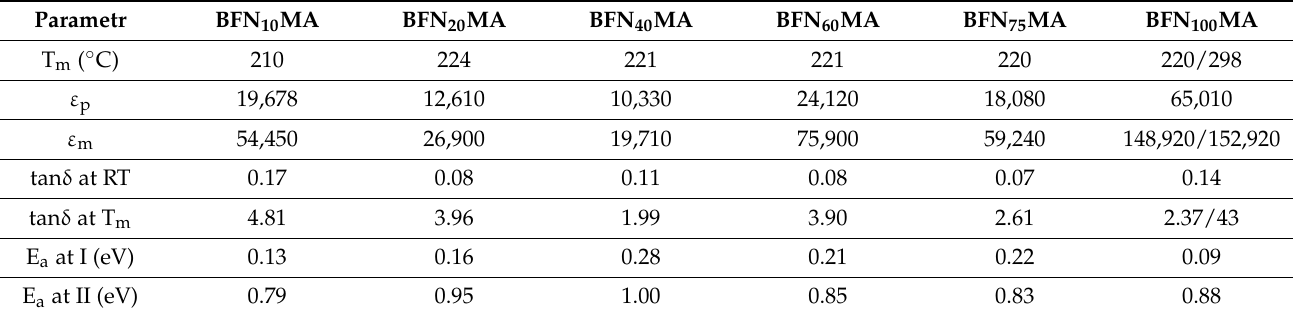
Table 2. Electrophysical properties of the BFN x MA